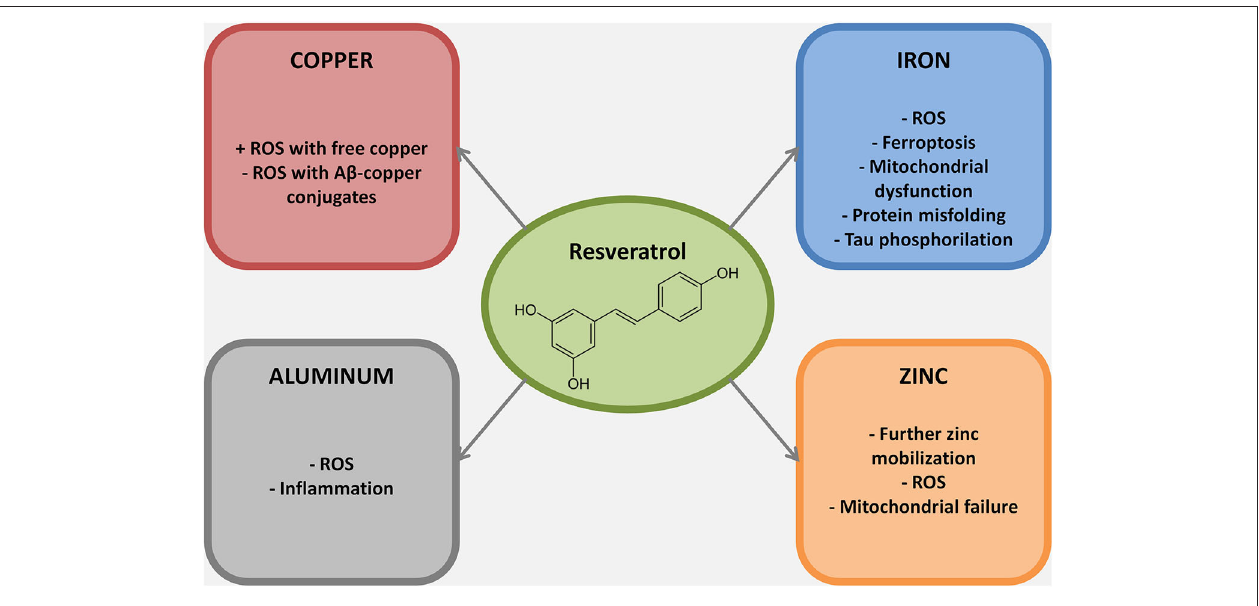
mechanisms through which resveratrol exert its neuroprotective role against selected metal ions are reported. Of note, most of the resveratrol beneficial effects against metal ion dyshomeostasis belong to its scavenging